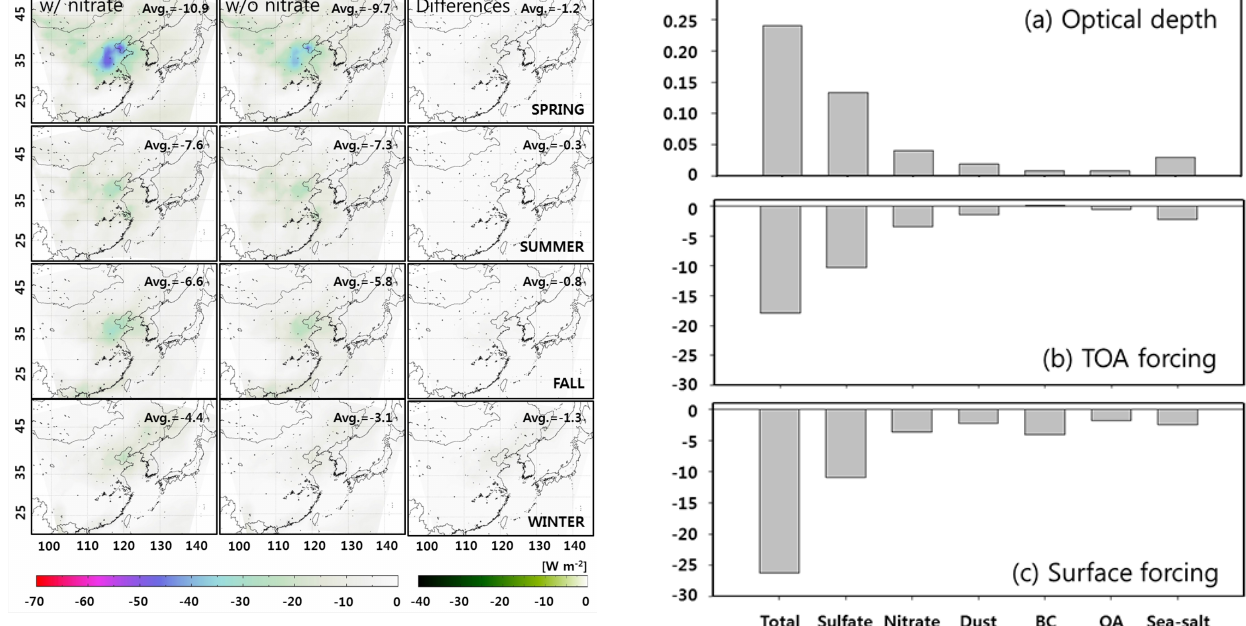
Fig. 16. Contributions of particulate species to (a) optical depth, (b) DRF by aerosols at the top of the atmosphere (TOA), and (c) DRF by aerosols at the surface for the year of 2006 over East Asia. The estimations were made based on the CMAQ model simula- tions. Therefore, it should be noted that the contributions of sulfate, organic aerosols (OAs), and black carbon (BC) can be underesti- mated due to possible underestimation of those concentrations in the CMAQ model simulations in East Asia (refer to Figs. 5 and 8 as well as Matsui et al., 2009; Luo et al., 2011; Park et al., 2011b; Kim et al.,